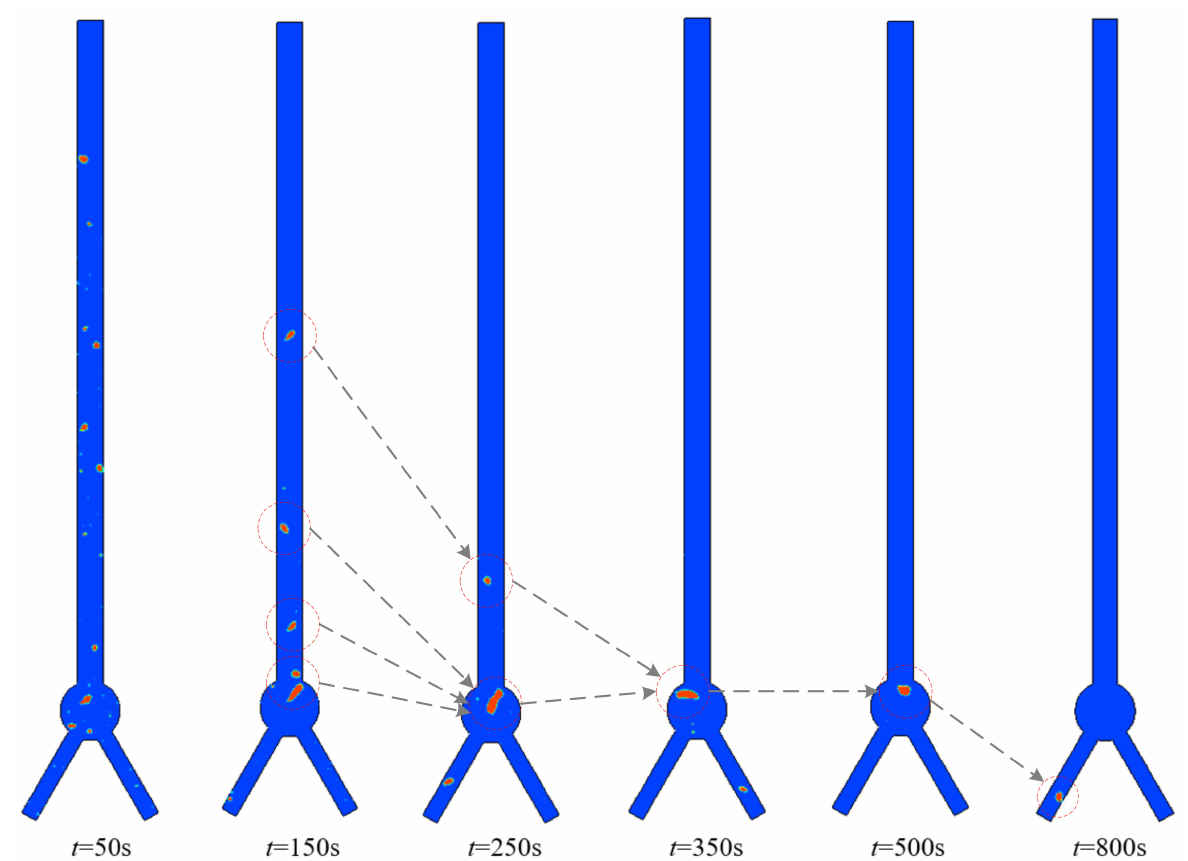
Figure 7. Bubble discharge characteristics under circulation liquid flow with m = 0.2